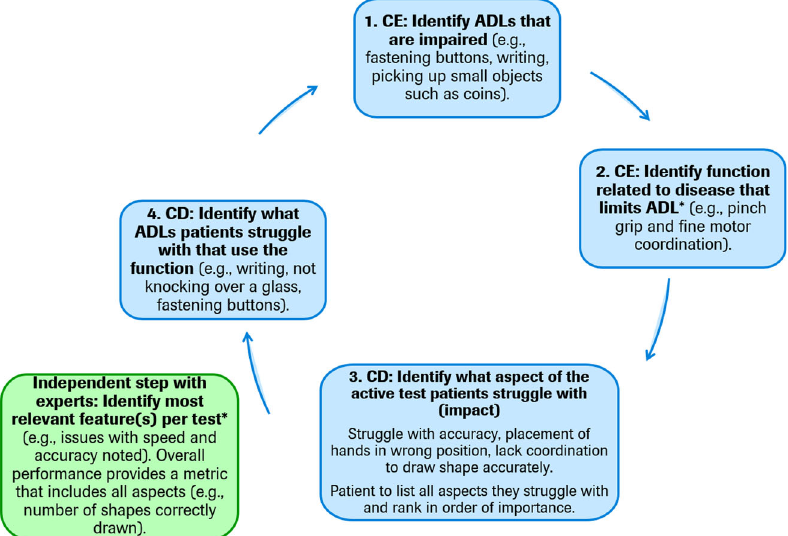
Fig. 4 Path towards identifying the sensor features of an existing DHTT which correspond best to patient relevant symptoms and impacts. Traditional semi-structured interviews (i.e., concept elicitation (CE) involving the identi fi cation of activities of daily living (ADLs) that patients feel are impacted by their disease), followed by the identi fi cation of the disease symptoms related to each impaired ADL. In a third step, patients interact with the DHTT and complete a given task (e.g., draw a shape) and are asked to identify which aspects of the DHTT task present challenges, and fi nally, the relationships between the symptoms and challenges presented by the DHTT task are identi fi ed. The last two steps may include a cognitive debrie fi ng (CD) interview to determine the patients ’ understanding of the task instructions and further establish the relevance of the DHTT assessment. All other potential ADLs related to patients ’ functions and DHTT sensor features should be discussed, represented by a return to the beginning of the interview procedure. The output of these interviews may lead to a re fi nement of the conceptual framework and associated DHTT if necessary, which should then be reviewed by experts (denoted by asterisk) to ensure a robust neurobiological mapping between symptoms and impacts and associated sensor features.